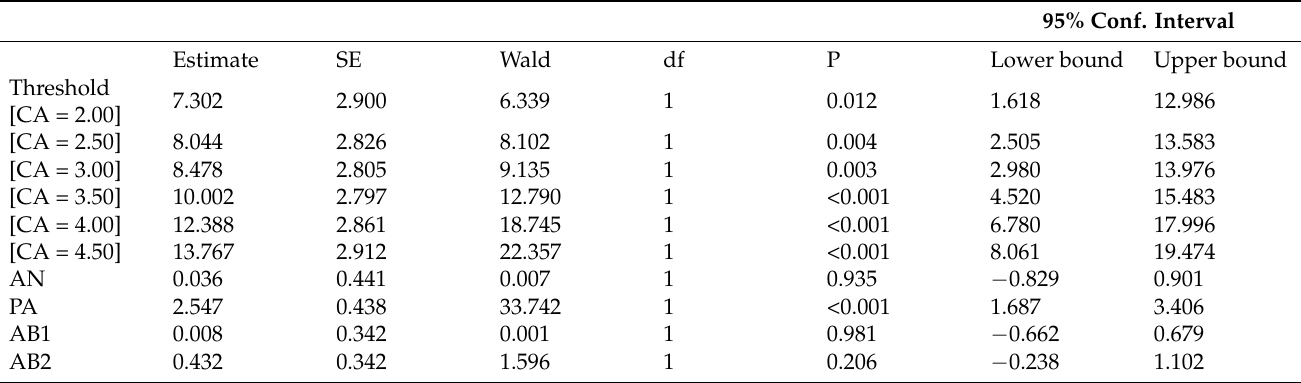
Table 1. Results of ordinal regression analysis.